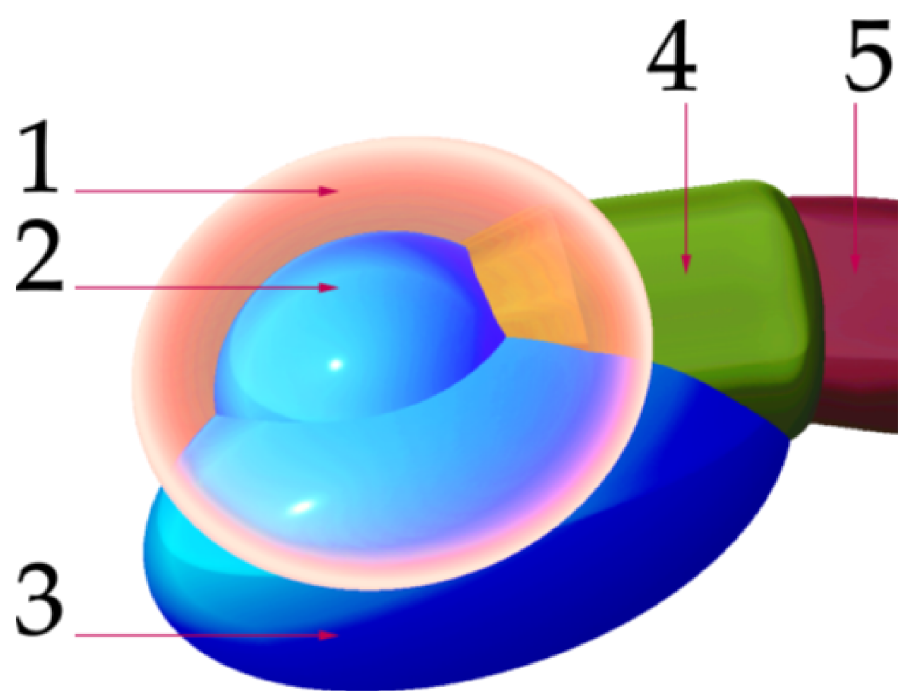
Figure 8. Main parts of the junction of both distalizers parts located on the smaller part intended for molar adhesion. (1) final encapsulation of the joint when merged with the base; (3) the body of the smaller part of the distalizer with a surface complementary to the surface of the molar, thus creating an individual base; (2) the socket of the joint; (4) extended neck of the accessory channel for the arm ending in the socket, liberating arm orientation during distalization and distorotation of the molar; (5) terminal part of the distalizer’s arm entering the socket with a sufficient gap around it;. Figure 9 visualizes the final merge of the distalizer parts, creating individualized bases, arm, and the socket in regard to the teeth (Figure